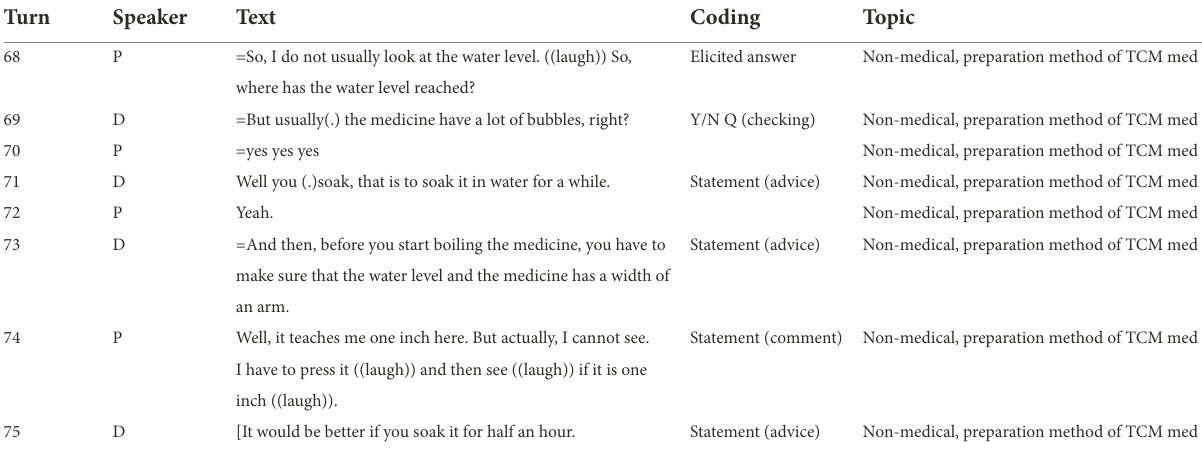
TABLE 5 Example of incorporating uncertainty into successful decision communication interventions during the medical